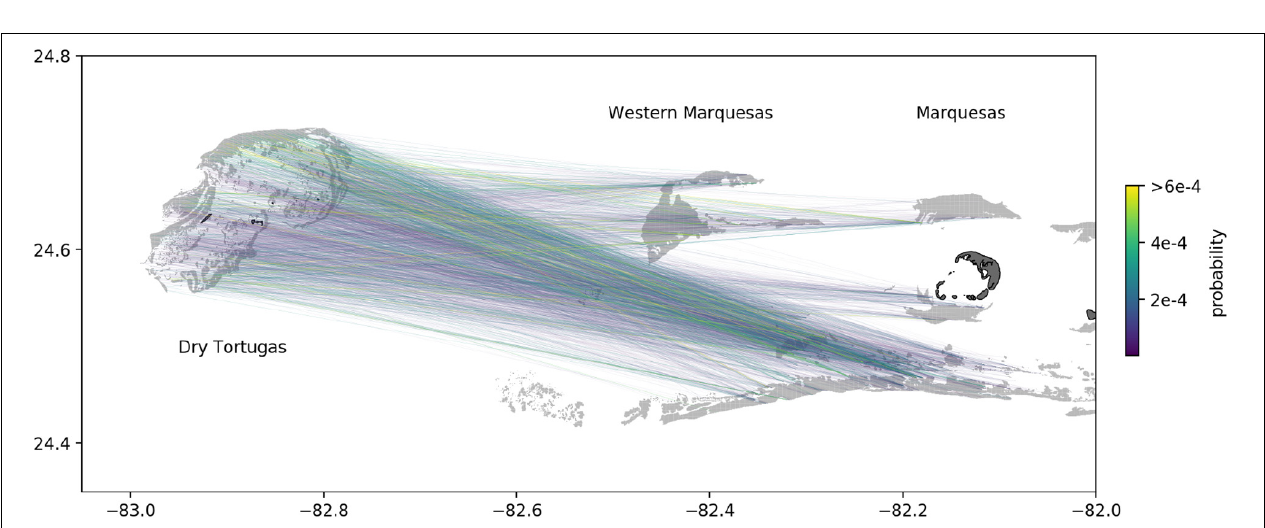
FIGURE 3 | Edges with largest connection probability to each sub-reef of the DRTO from the Marquesas and the Western Marquesas in November 2020. Connections mostly originated from the southern reefs between the Marquesas and Western Marquesas, and from the northwestern reefs of the Western Marquesas. Reefs are highlighted in light gray while islands are shown in dark